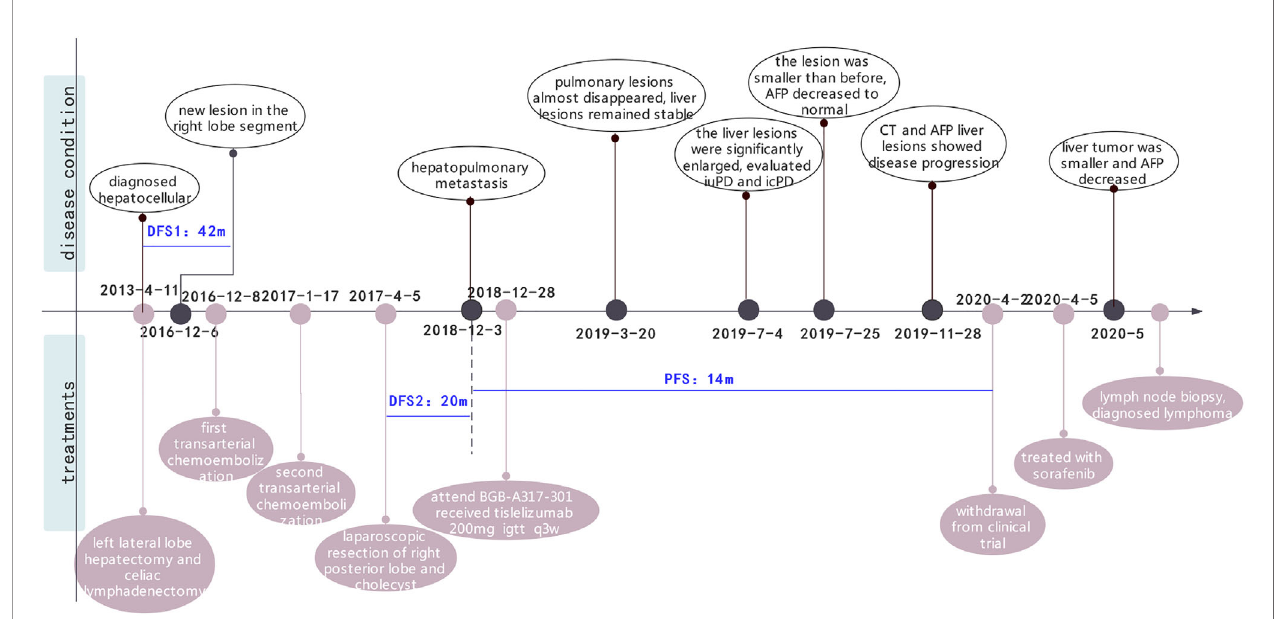
FIGURE 2 | The whole clinical timeline of the patient, with major treatment and disease status. DFS, disease-free survival; PFS, progression-free